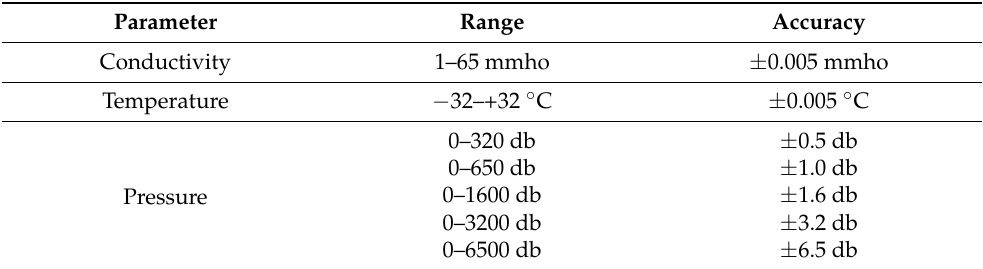
Table 1. Specifications of the conductivity, temperature and depth (CTD) instrument used in this